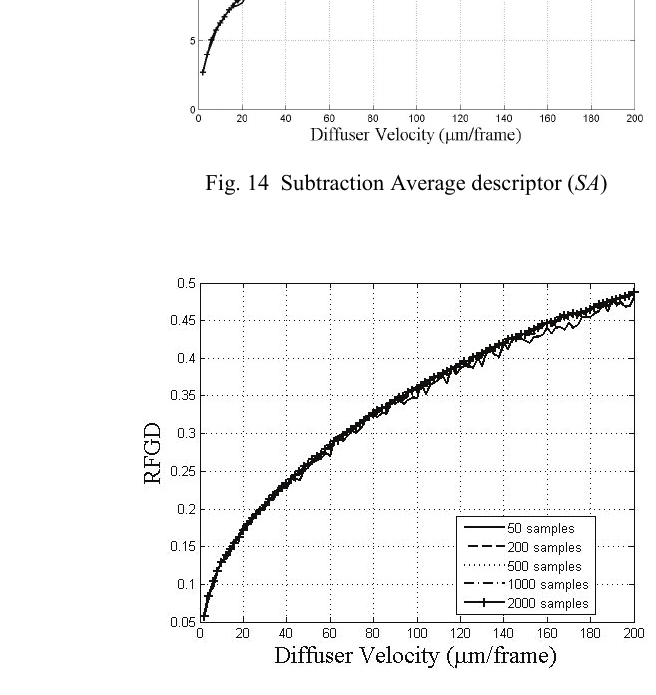
Fig.12 Generalized Differences descriptor ( GD )